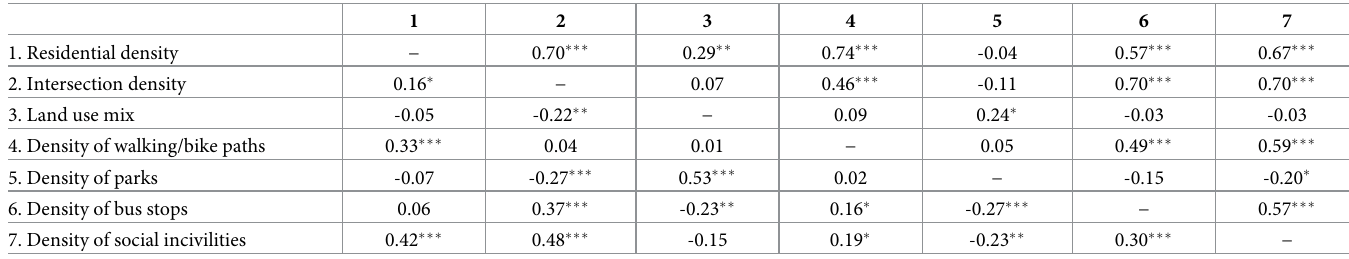
except for land use mix, where the values for suburbs were larger than those for neighbor- hoods. This is because suburbs are larger and tend to include more different land uses. Table 2 shows Pearson’s correlation coefficients of environmental attributes at the neigh- borhood level (lower left half) and at the suburb level (upper right half). Correlation coeffi- cients were generally larger at the suburb level, where some coefficients were 0.7 and over, than at the neighborhood level, where the largest coefficient was around 0.5. Table 3 shows Table 2. Pearson’s correlation coefficients between environmental